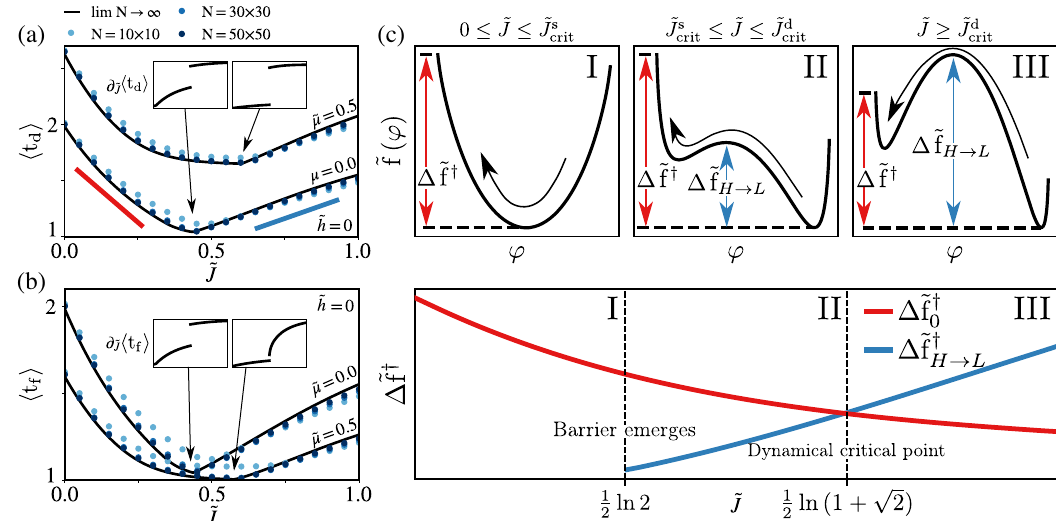
FIG. 8. Master scaling of mean dissolution and formation times per bond for finite clusters and in the thermodynamic limit, and the ˜ J origin of the dynamical critical point. (a) h t for cluster dissolution and (b) formation as a function of the coupling for a pair of d ; f i intrinsic affinities ˜ μ ¼ 0 and ˜ μ ¼ 0 . 5 and various cluster sizes (symbols) as well as the thermodynamic limit (lines) in the absence of an [Eqs. (6) and (8)] and ¯ w from external force. Symbols are evaluated with the local equilibrium approximation, Eq. (23), using Q BG k → k þ 1 k Eq. (21). The discrepancy between the lines and symbols is due to finite-size effects. (c) In the thermodynamic limit and, more generally, for large clusters, the mean dissolution or formation time h t depends only on the largest free energy barrier [see Eq. (24)]. For small d ; f i coupling (regime I), the latter corresponds to the difference between the free energy minimum and the fully dissolved or bound ˜ ˜ ˜ J s f † 0 , respectively. At the statical critical coupling value, (onset of regime II), a free energy barrier emerges, configuration, Δ f † ¼ Δ ; 1 crit ˜ ˜ ˜ separating the metastable from the stable phase, Δ f † , but the largest free energy barrier is still Δ f † ¼ Δ f † 0 . At the dynamical critical H ⇄ L ; 1 ˜ J d coupling, (onset of regime III), the free energy barrier separating the metastable from the stable phase becomes dominant, crit ˜ ˜ Δ ˜ f † ¼ Δ ˜ f † h ¼ 0 . The depicted free energy landscapes f ð φ Þ correspond to Eq. (12) with ˜ μ ¼ 0 . 05 and H ⇄ L